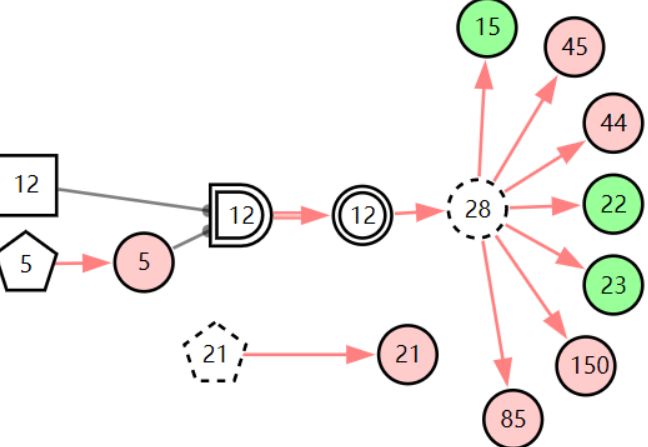
Figure 5. The graphic interpretation of chronic laryngitis when E (cid:48) = X 7,4 X 52,1 X 85,1 X 21,1 X 15,1 X 45,1 X 44,1 X 150,1 X 5,1 .